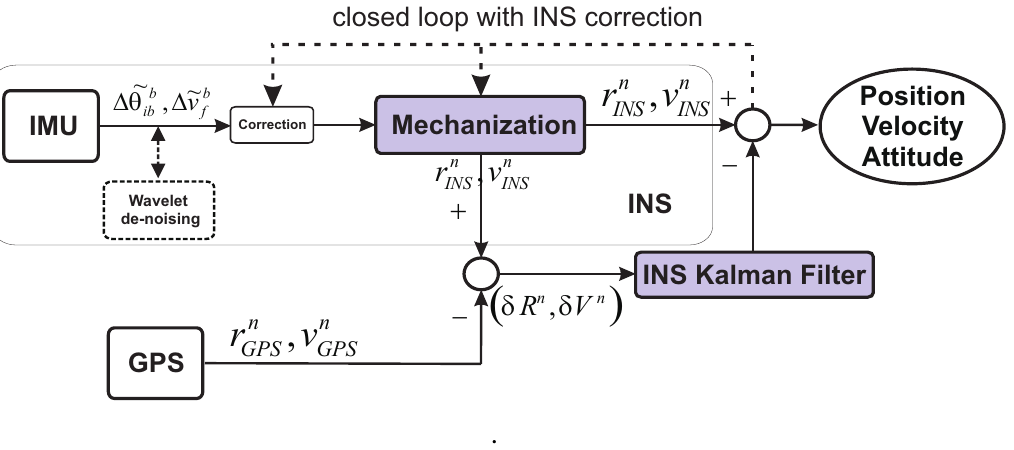
Figure 3. Loosely-coupled Kalman Filter (KF) integration with feedback; figure kindly taken from